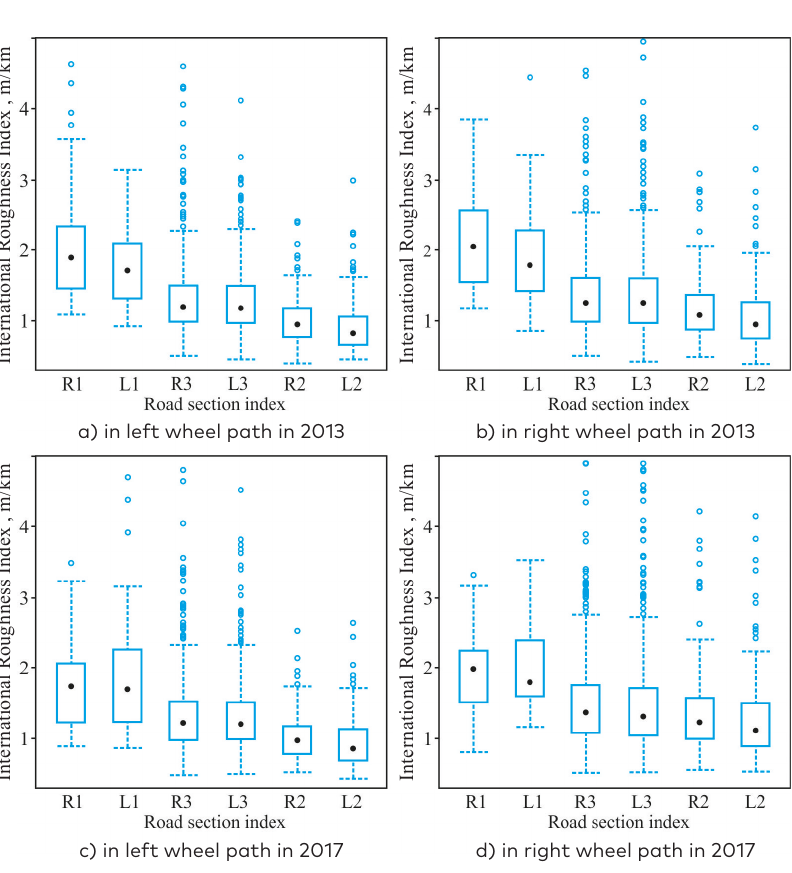
its standard deviation in the left and right wheel paths, as well as the IRI critical limit of 1.5 m/km. Road section from 35.300 km to 38.800 km, in which RAP was bound with cement in 2003 (L2 and R2), showed the best performance according to IRI in both 2013 and 2017. In 2013 in this section, the mean of IRI was 0.896 m/km (L2) and 1.003 m/km (R2) in the left wheel path and 1.074 m/km (L2) and 1.181 m/km (R2) in the right wheel path. In 2017 the mean of IRI in the left wheel path was almost the same (0.945 m/km (L2) and 1.012 (R2)) as in 2013; however, in the right wheel path, it increased by